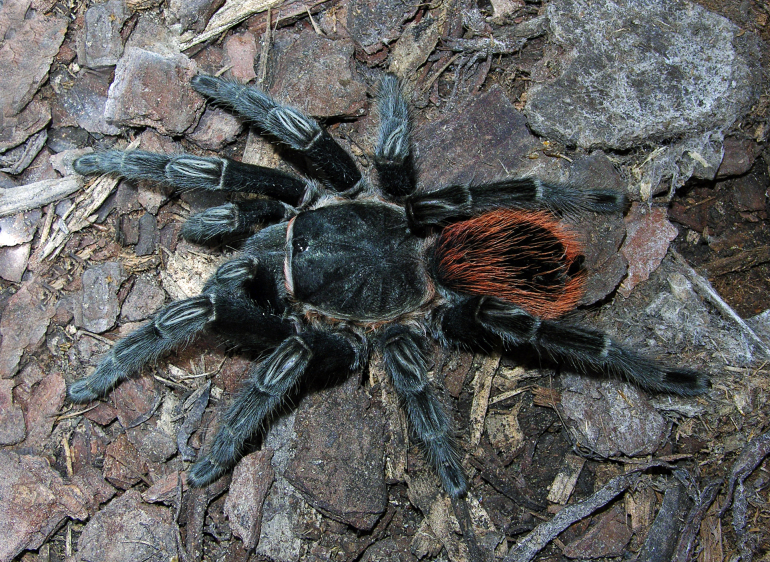
Brachypelma
epicureanum (Chamberlin, 1925) female from Mérida, Yucatán, Mexico. Photo: Rick C. West.